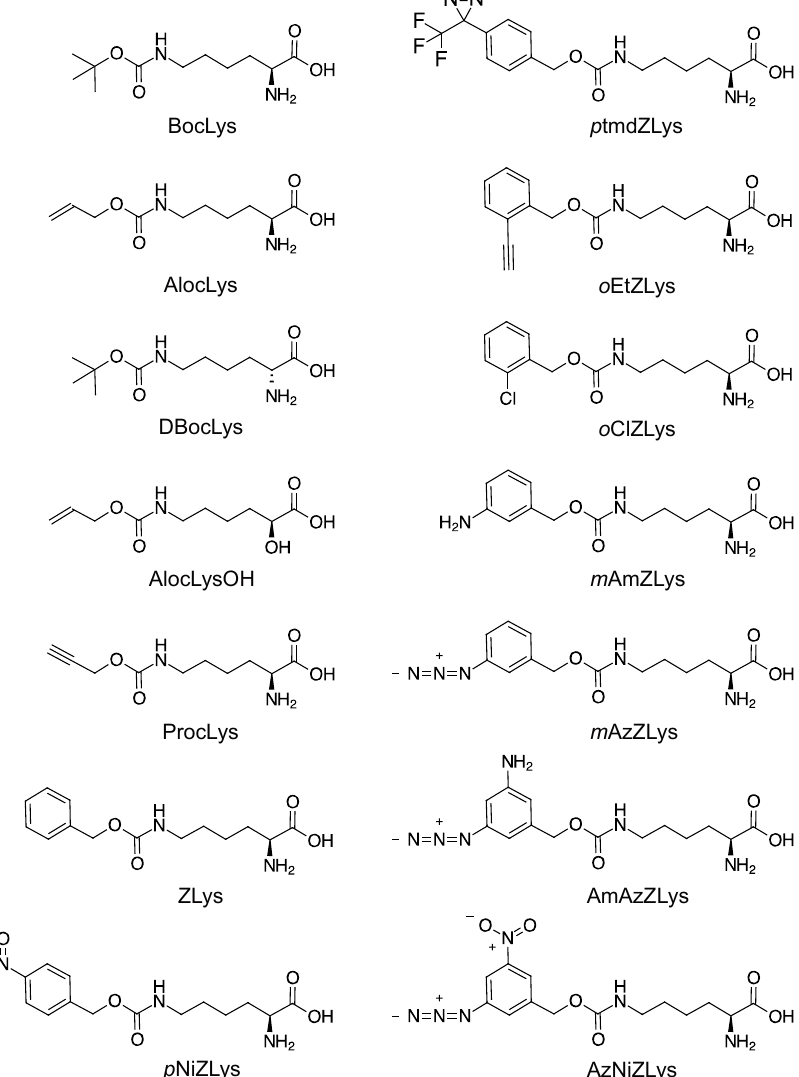
Scheme 1. Chemical structures of lysine derivatives.